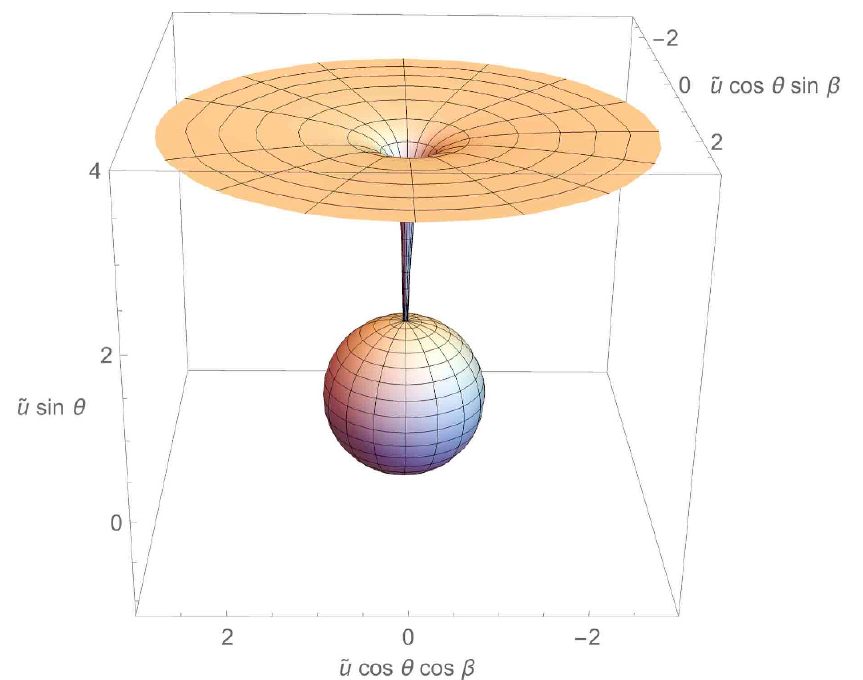
Figure 2. A plot of a Black hole embedding mimicking a Minkowski embedding connected with a D3-brane throat to the horizon. The dashed vertical line represent the critical parameter ~ m cr at which the phase transition takes